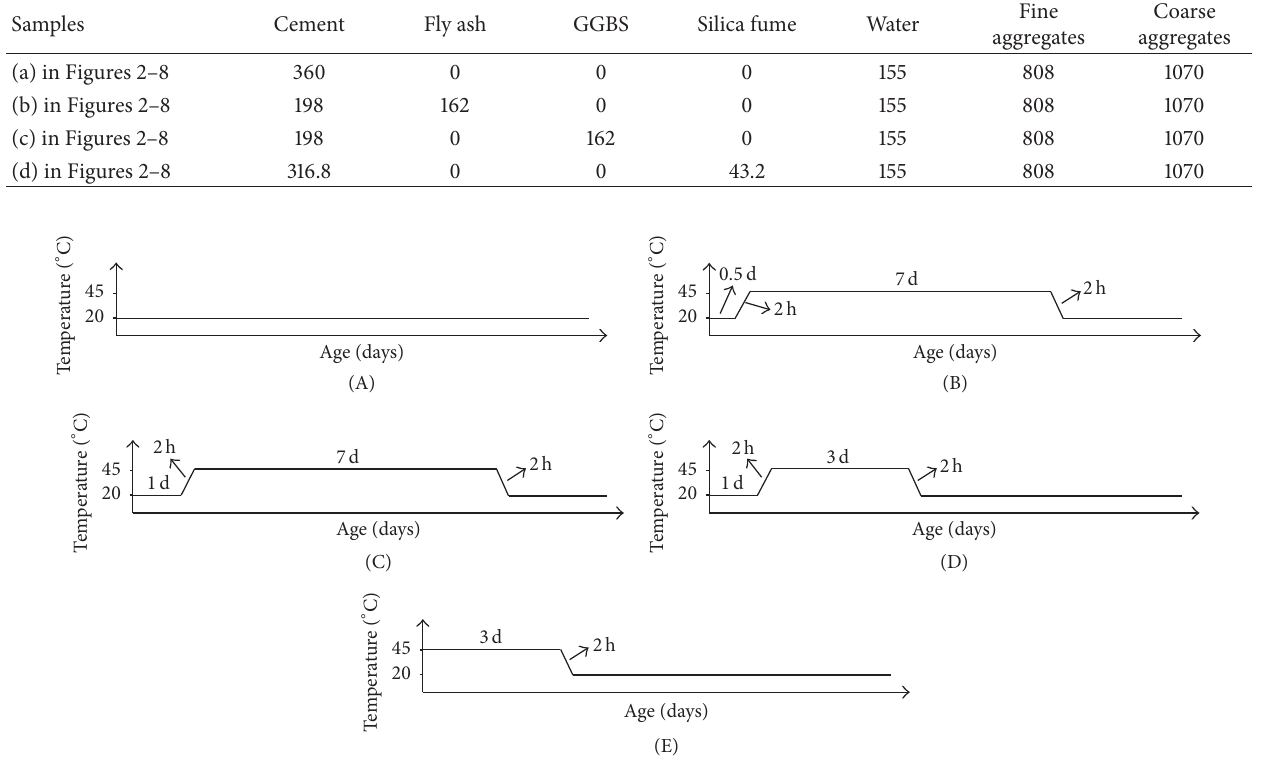
Table 4: Mix proportion of concretes/(kg/m 3 ).